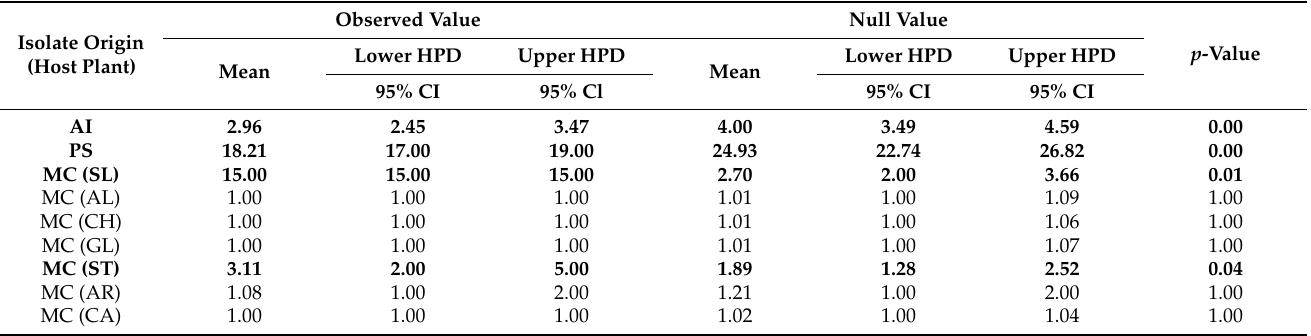
Table 4. Bayesian statistic measuring the association between host plant and clustering observed in the MCC tree. Statistical supported values are bolded.